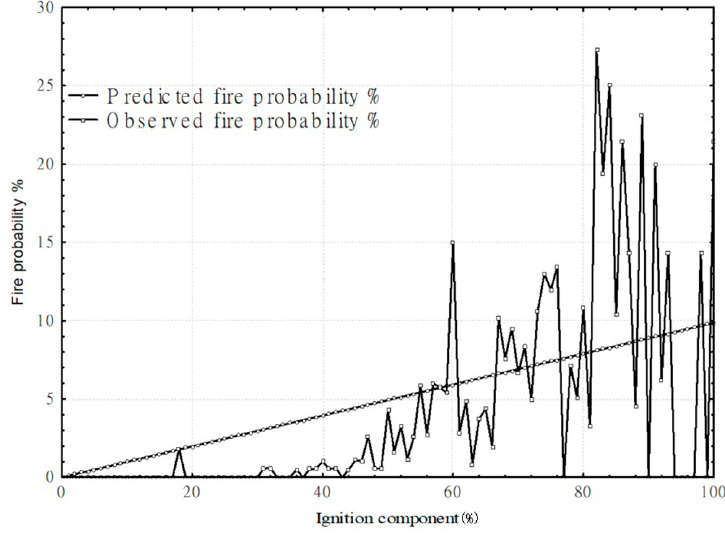
Figure 5. Predicted and observed daily fire probability for the period of 1976–2008.